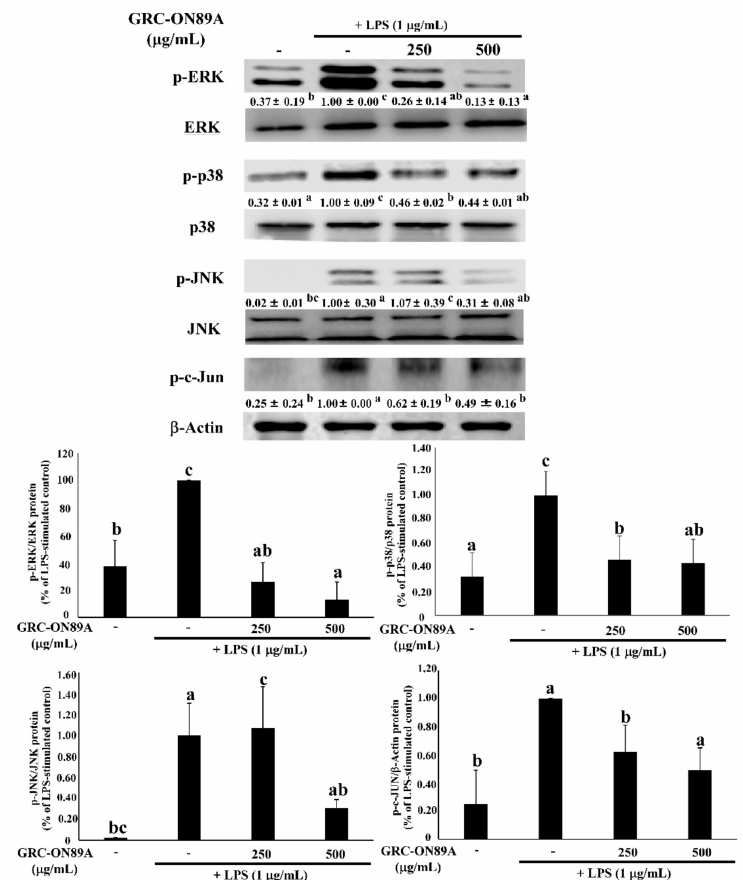
Figure 5. GRC-ON89A-Hex suppresses the phosphorylation of mitogen-activated protein kinase (MAPKs) in LPS-stimulated RAW264.7 macrophages. Macrophages were pre-incubated with GRC-ON89A-Hex for 12 h and then incubated with LPS (1 µ g/mL) for 20 min. One-way analysis